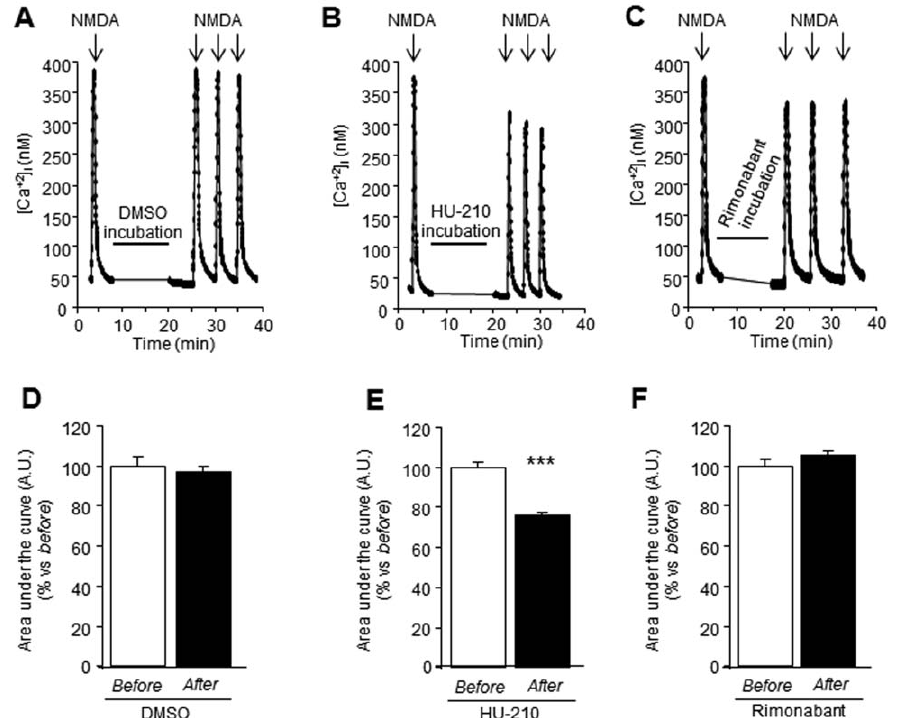
Figure 5. The stimulation of the endocannabinoid system reduces NMDA-stimulated calcium influx in ethanol-withdrawn neurons. (A, B, C) Representative recordings of single-cell calcium videomicroscopy for each experiment. A 30 sec exposure to NMDA (50 m M) produced a rapid calcium influx, which recovered over the following 2 min ( before ). (E) After the incubation (10 min) with the non-specific CB1 agonist HU-210 (1 m M), Ca 2 + influx (induced by NMDA application) is significantly decreased in comparison to the stimulation before . Incubation (10 min) with DMSO (D) or rimonabant (1 m M) (F) does not modify NMDA-stimulated calcium influx. Values are expressed as % vs. before NMDA-stimulation 6 SEM (N=3–4; n (cell number) . 60 cells). Data were analyzed by the t Student’s test. (*** P , 0.001).